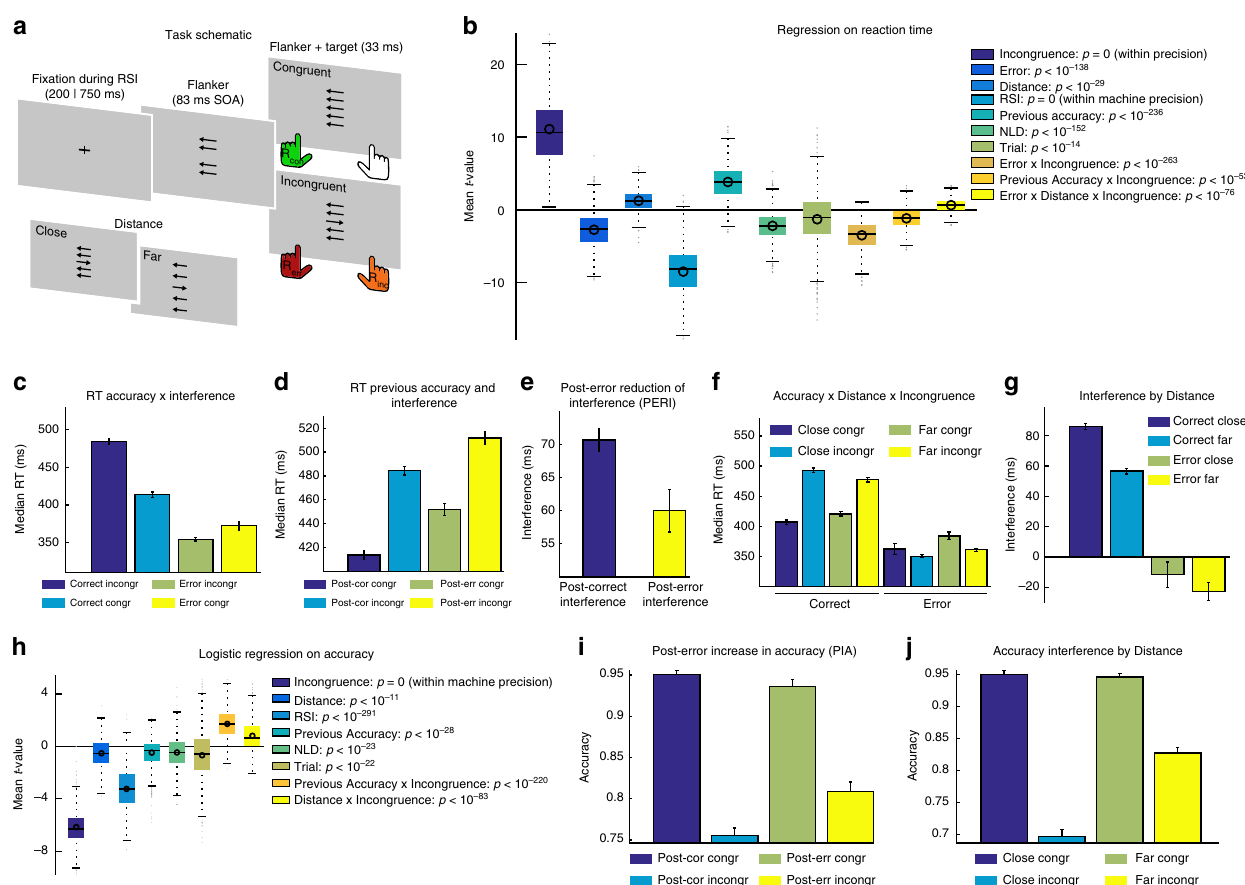
Fig. 1 Task and behaviour. a In the fl anker task either congruent or incongruent fl ankers (four surrounding arrows) in close proximity or further away from the central target (inlet) are presented on each trial. Congruent stimuli usually yield faster responses (green) compared to incongruent stimuli, which lead to delayed responses (orange) or induce errors (red). b Multiple single-trial regressions on RT and logistic regression on accuracy ( h ) were used to evaluate participant ’ s behaviour in the task while controlling for confounds and the interdependence of effects. We con fi rm that stimulus incongruence increases RT and decreases accuracy, while interacting with the distance between fl ankers and target ( f , j ) for both speed and accuracy. Additionally, RT changes depending on stimulus interference interact with accuracy: on error trials, incongruent stimuli have lower RT than congruent stimuli ( c ). Interference effects are furthermore reduced following errors with regard to both reaction speed and accuracy ( d , e , i ). b , h display average within participant t -values, p -values are derived from t -tests of individual regression weights against zero. Interference effects are calculated by subtracting RT ( e , g ) in the congruent from the incongruent condition. RT is calculated as the mean of within-participants median RTs per condition, RSI = response stimulus interval, NLD = distance since last break. For b , h , boxes = interquartile range (IQR), o = median, - = mean, whiskers = 1.5 × IQR, grey dots = outlier. Error bars represent 99.9% CI; d , e include correct trials